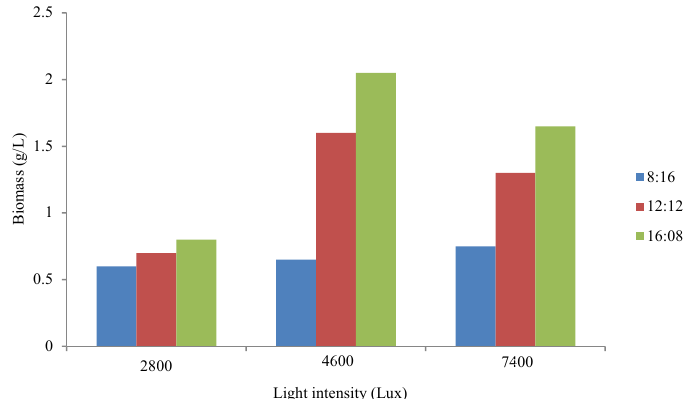
Fig. 3: Chlorella vulgaris biomass in the three periods and three different light intensities (Brody and Vatter, 1959)